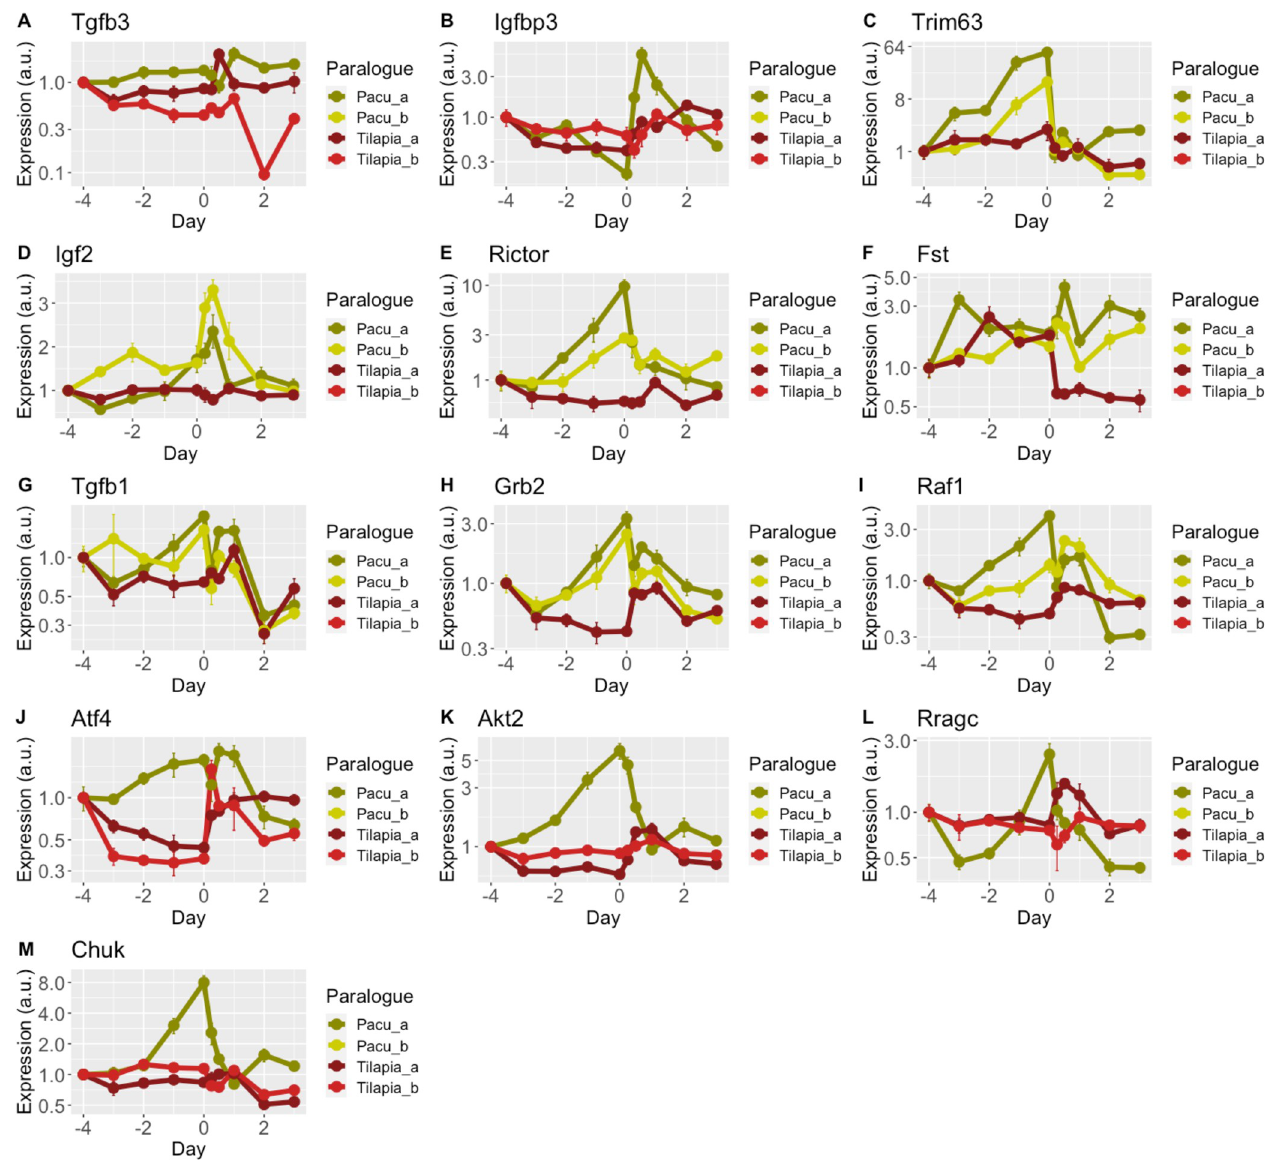
Fig 4. Lineage-specific ohnologs (LSOs) retained by subfunctionalization or neofunctionalization. Gene duplicates showing signs of subfunctionalization and neofunctionalization as the main molecular mechanisms of retention. LSOs and singletons expression of (A) transforming growth factor 3 ( tgfb3 ), (B) insulin like growth factor binding protein 3 ( igfbp3 ), (C) tripartite motif containing 63 ( trim63 ), (D) insulin like growth factor 2 ( igf2 ), (E) rptor independent companion of mtor complex 2 ( rictor ), (F) follistatin ( fst ), (G) transforming growth factor beta 1 ( tgfb1 ), (H) growth factor receptor bound protein 2 ( grb2 ), (I) raf-1 proto-oncogene , serine/threonine kinase ( raf1 ), (J) activating transcription factor 4 ( atf4 ), (K) akt serine/threonine kinase 2 ( akt2 ), (L) ras related GTP binding c ( rragc ), (M) component of inhibitor of nuclear factor kappa B kinase complex ( chuk ) in pacu (green lines) and tilapia (red lines) skeletal muscle are represented as relative values, Mean ± SE (n =